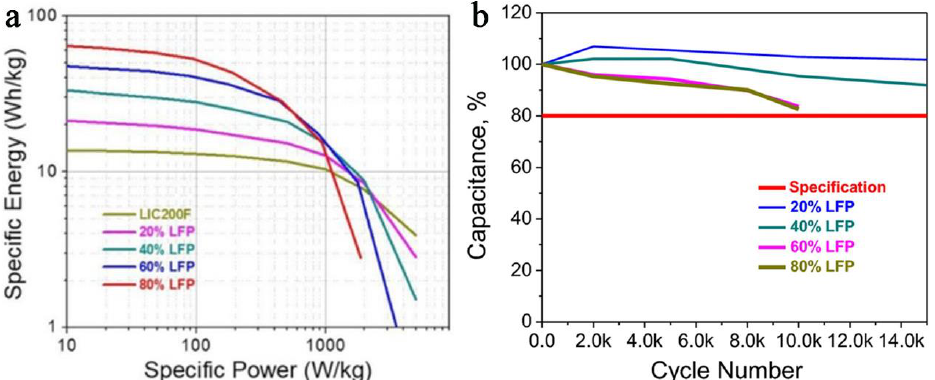
Figure 17. LIBCs with different battery material contents in the cathode: ( a ) Ragone plot; ( b ) Cycle performance [101].